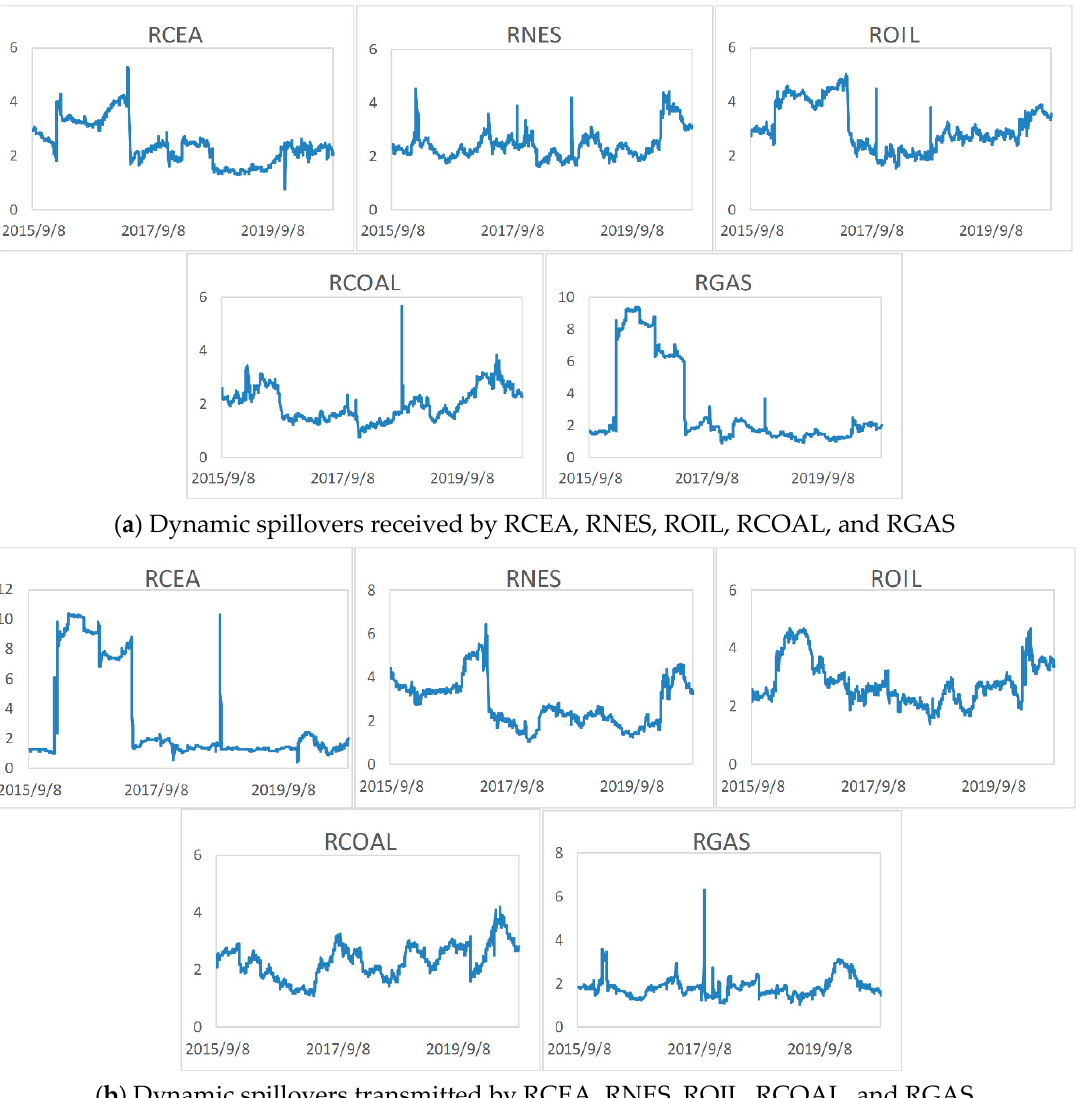
Figure 5. Dynamic spillovers of the carbon market, new energy stock market, and fossil energy markets. The length of the rolling window is 300 days and the date in the figure is the last day of each rolling